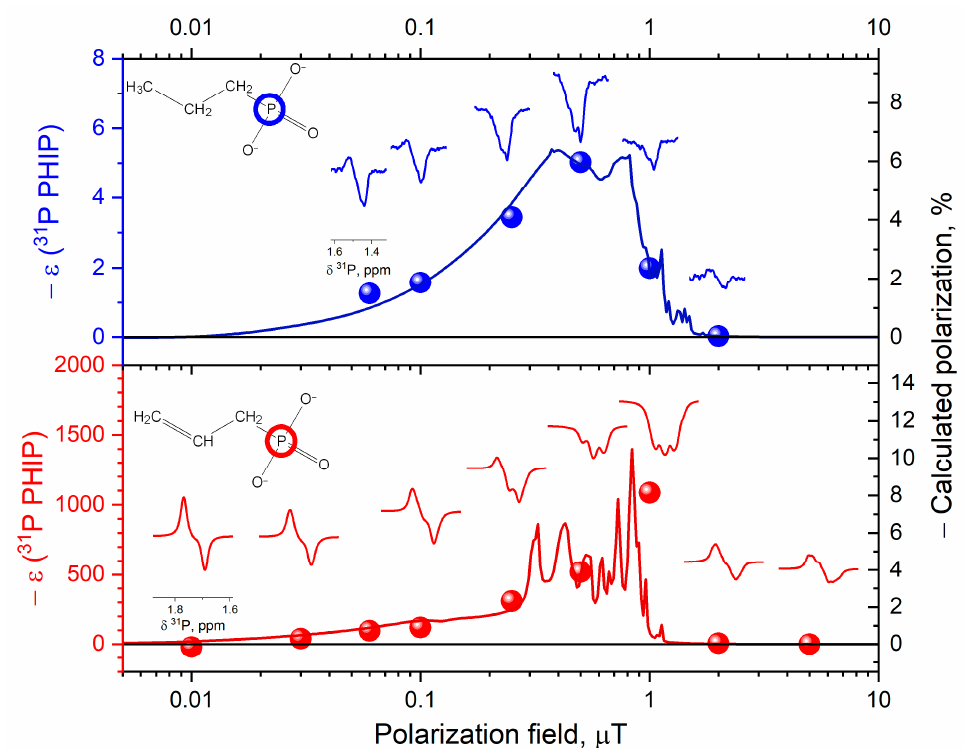
Figure 4. The signal amplification and polarization levels of the 31 P nuclei upon the polarization transfer by magnetic field-dependent hydrogenation by parahydrogen. The blue and red circles are the experimental values of the 31 P signal amplifications, and the solid lines show the best fits by the numerical model that employed spin–spin coupling and chemical shifts from high-field 1 H and 31 P NMR spectra (see SI) and neglected the relaxation effects. The polarization scale of the calculated curves is adjusted to guide the eye.